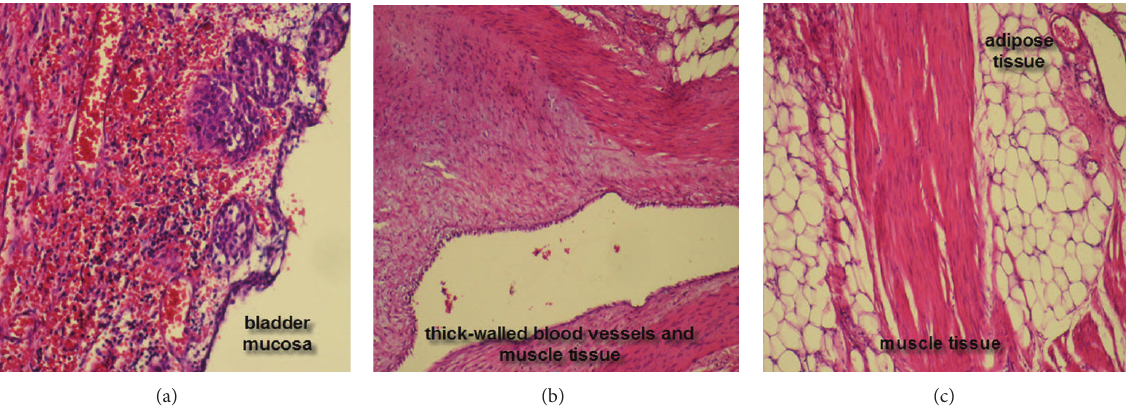
Figure 3: Histology of bladder mass. Tumor is composed of adipose tissue, thick-walled blood vessels, and muscle tissue. H&E × 200.